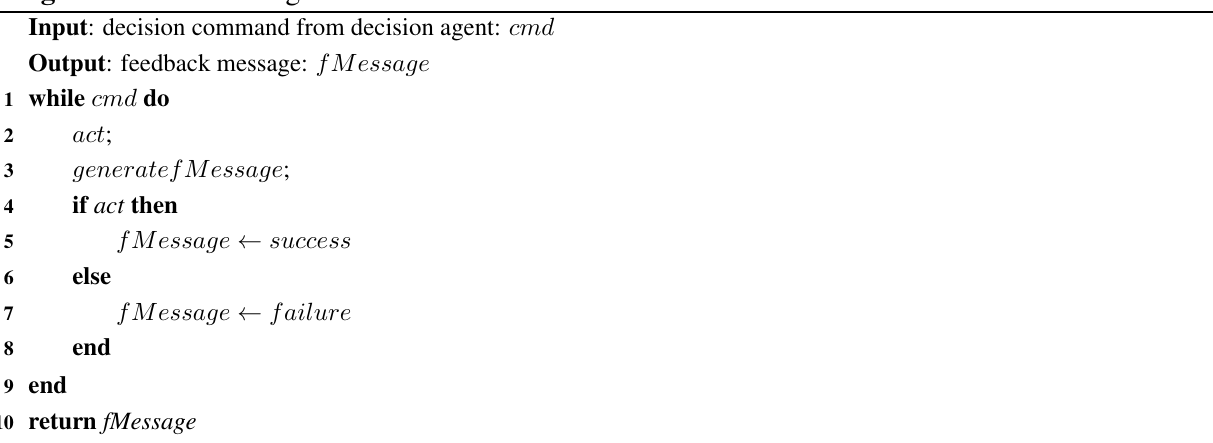
Algorithm 5 : Action agent